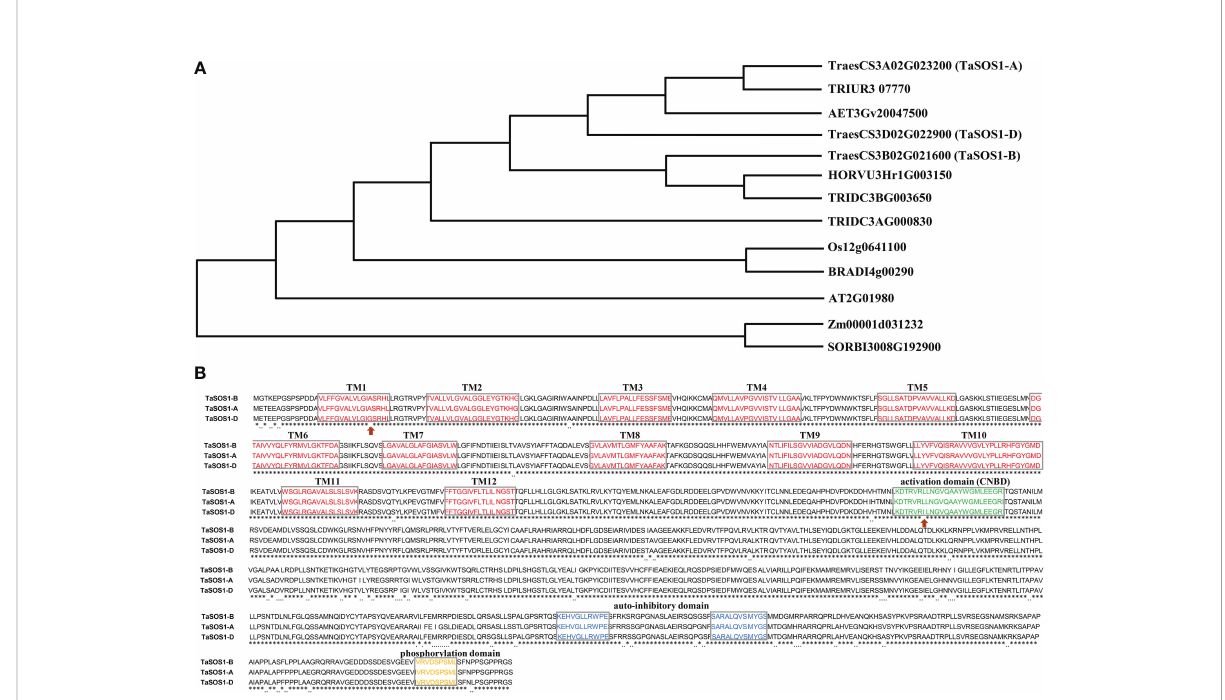
FIGURE 1 Sequence analysis of three TaSOS1 homoeologous genes. (A) Phylogenetic relationship analysis of three TaSOS1 homoeologs with other members in multiple species. The accession numbers of selected species and gene IDs are listed as Table S3. (B) Comparison of amino acids in three TaSOS1 homoeologs. Identical amino acids are indicated by asterisks, gray boxes indicate conserved domains among the three proteins, and the red arrows indicate amino acid difference within the conserved domains among three TaSOS1